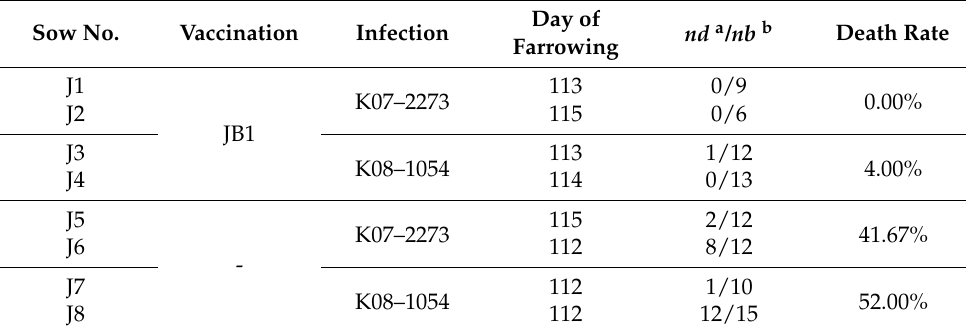
Table 3. Summary of the reproductive evaluation